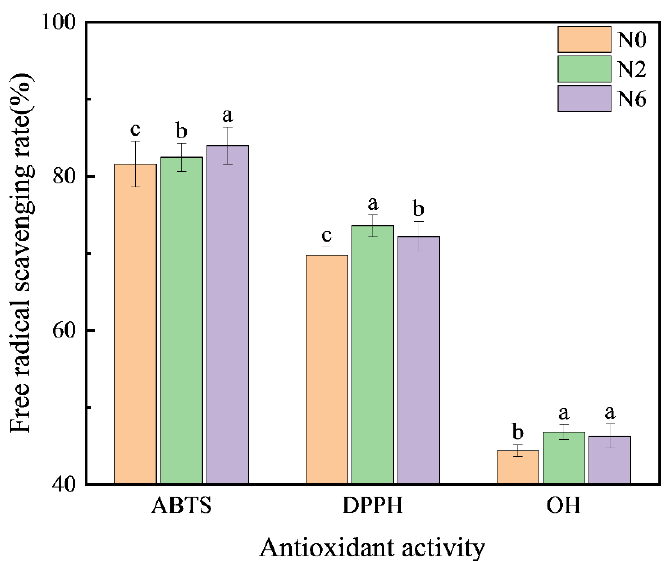
Figure 4. Antioxidant activity of brown rice at different amounts of nitrogen fertilisation. Values of each bar with no letters in common are significantly different ( p <